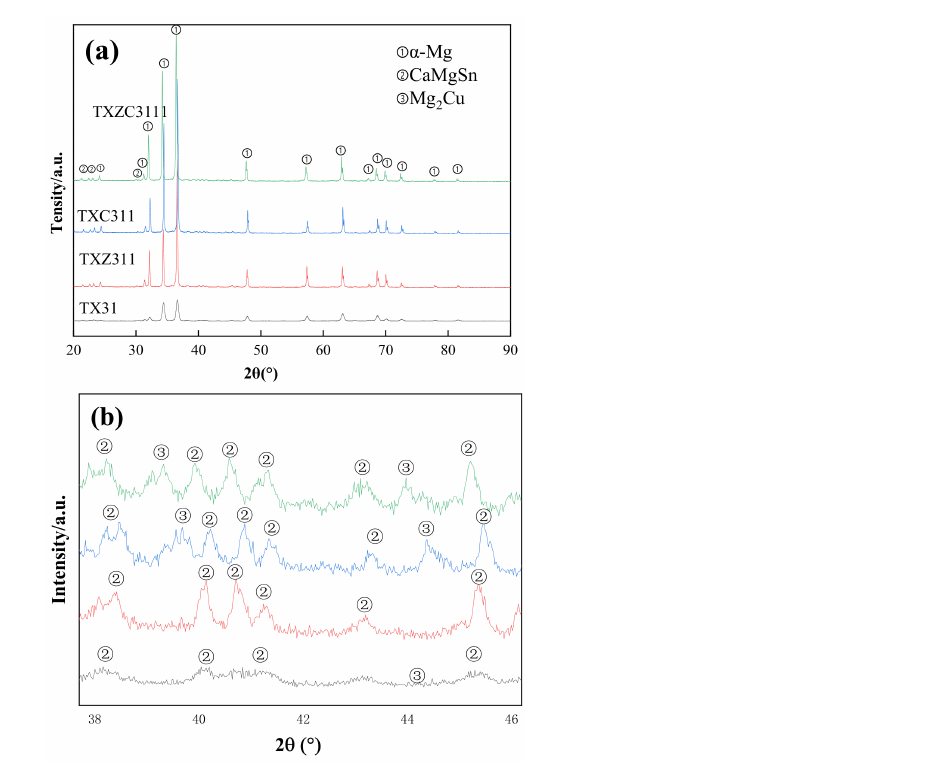
Figure 4. XRD patterns of the as-extruded alloys, ( a ) scan angle 20 ◦ ~90 ◦ ; ( b ) scan angle 37 ◦ ~47 ◦ .